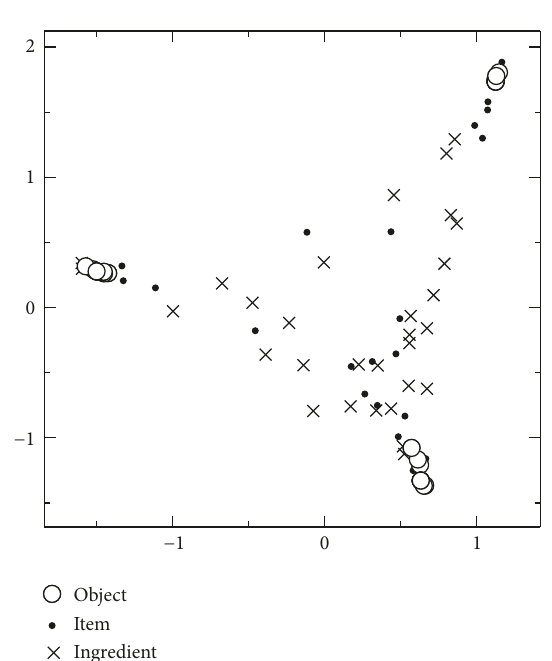
Figure 7: 2D Plots given by multicorresponding